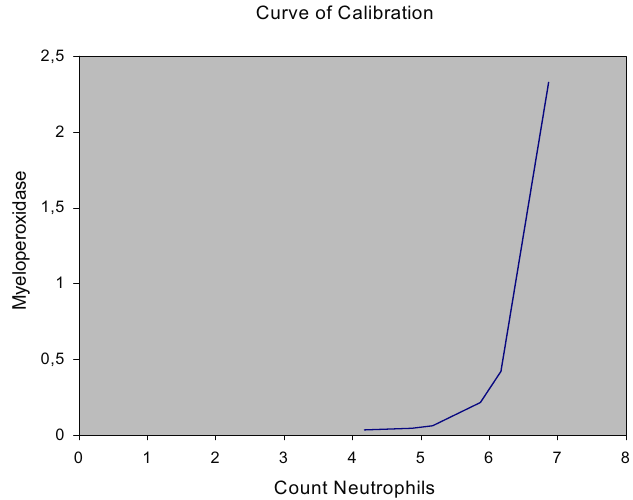
FIGURE 1 – Graph with the interpoled values on the calibration curve